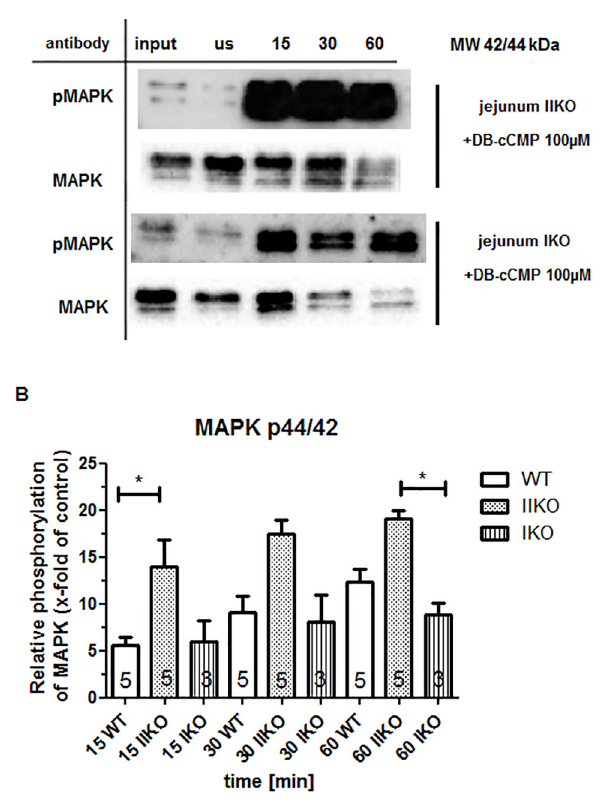
Fig 8. Activation of MAPK by cCMP in (A) cGKII KO tissue or in cGKI KO tissue (both jejunum tissue lysate). Tissue lysate was stimulated with 100 μ M DB-cCMP for the indicated times (15/30/60 min). As control, untreated (1 μ g/ μ L, indicated with input) and unstimulated tissue lysate (2.5 μ g/ μ L, indicated with ‘ us ’ ) was used. Control samples ( ‘ us ’ ) were treated like DB-cCMP stimulated samples but, instead of DB-cCMP, water was added. The phosphorylation of MAPK was detected by immunoblotting using a pMAPK antibody. Total MAPK was measured by stripping the membrane and retreating with the respective antibody. (B) Densitometry analysis of 3 – 5 independent experiments (numbers in columns) was performed to quantitate p44/42 MAPK levels. Data were expressed as x-fold MAPK phosphorylation relative to untreated control samples. cGKII KO and cGKI KO data were compared with WT data. Error bars show mean ± SEM. Asterisks indicate statistically significant differences, ns: not statistically significant. The same experiment was conducted with lung tissue lysates (S7